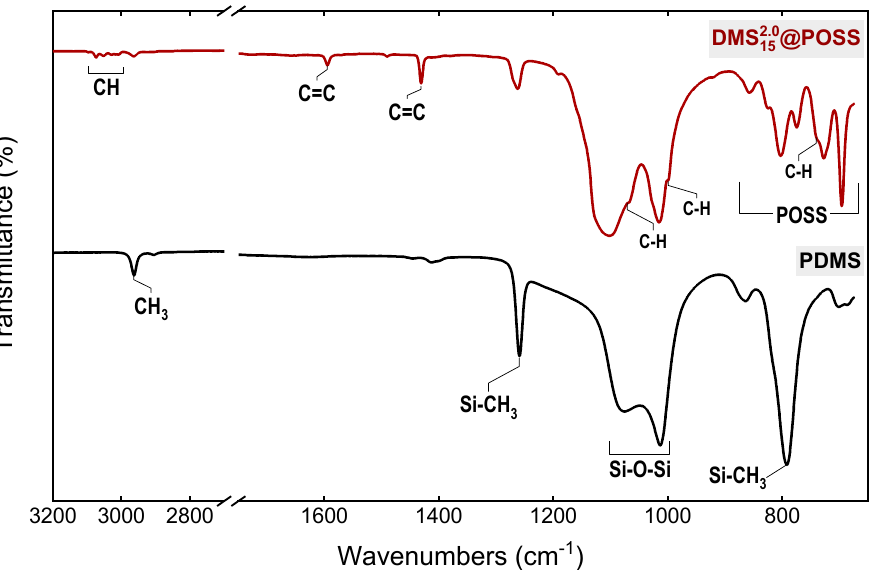
Figure 3. ATR-FT-IR spectrum of the DMS 2.0 15 @POSS membrane (upper spectrum) compared to a spectrum of conventional silicone rubber membrane (bottom spectrum).